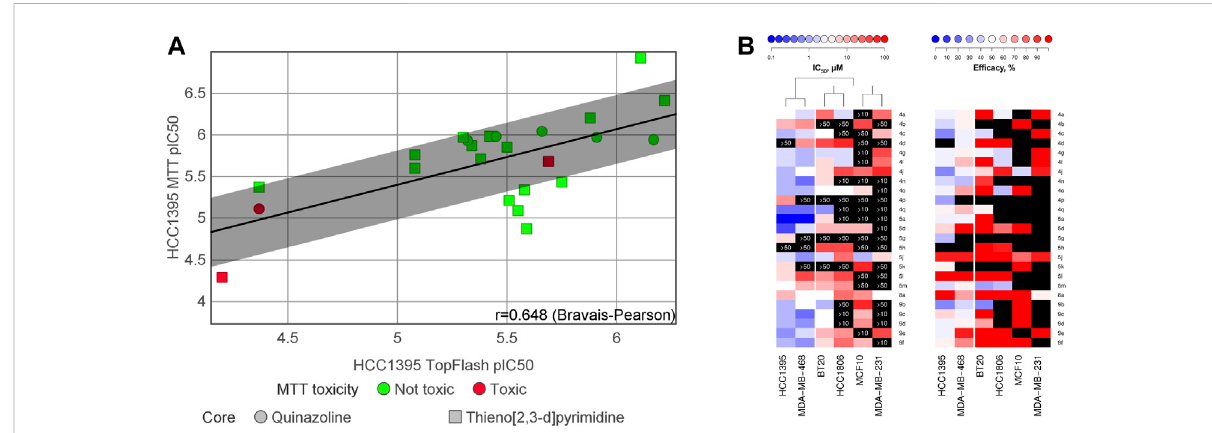
FIGURE 3 (A) CorrelationbetweeninhibitionoftheWnt-pathway (measuredbytheTopFlashassay)andinhibitionofTNBCcellproliferation(measuredby the MTT assay). “ MTT toxicity ” refers the ratio between the cell proliferation IC 50 measured on MCF10a (non-cancerous breast cells) by the IC 50 measured on HCC1395 (TNBC cells); “ Not toxic ” refers to this ratio being less than 3-fold. (B) Heatmaps summarizing IC 50 and ef fi cacy of the compounds against diverse TNBC cell lines and the control non-cancerous MCF10a cell line. Only compounds that had previously demonstrated a speci fi c anti-Wnt activity in HCC1395 cells were tested; black blocksindicate no activity within the tested concentration range, with the maximal tested concentration indicated on the block. HCC1395 and MDA-MB-468 cell lines compose a distinct cluster with overall higher susceptibility to the compounds, whereas the other tested TNBC cell lines cluster together with MCF10a cells, demonstrating lower